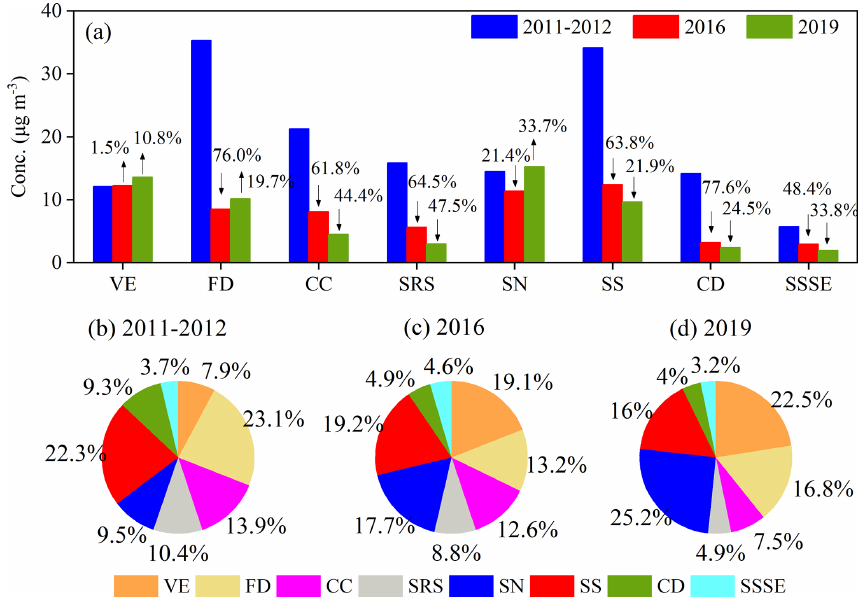
Figure 5. Changes in source contributions for 2011–2012, 2016, and 2019. VE represents vehicle emissions, FD represents fugitive dust, CC represents coal combustion, SRS represents steel-related smelting, SN represents secondary nitrate, SS represents secondary sulfate, CD represents construction dust, and SSSE represents sea salt and ship